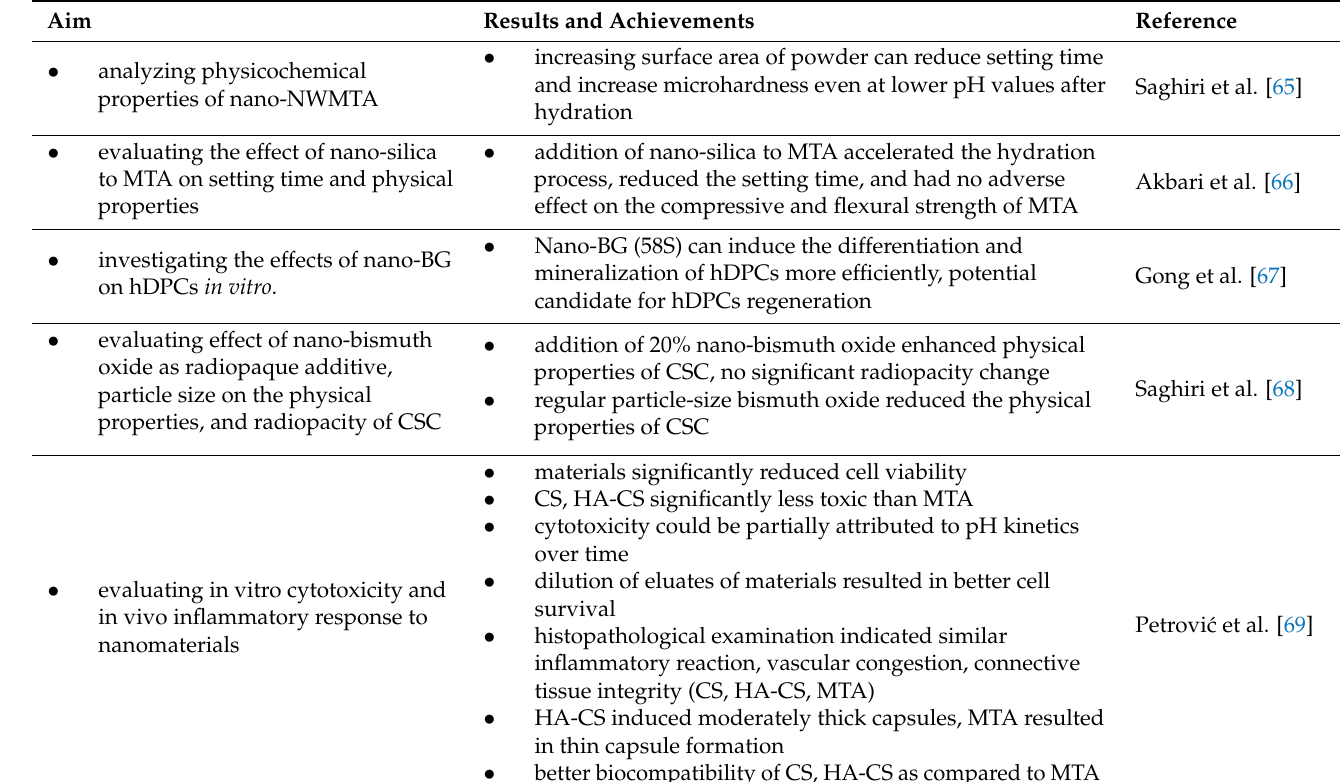
Table 2. Achievements related to nanotechnology applications in endodontics: nano-improvement of